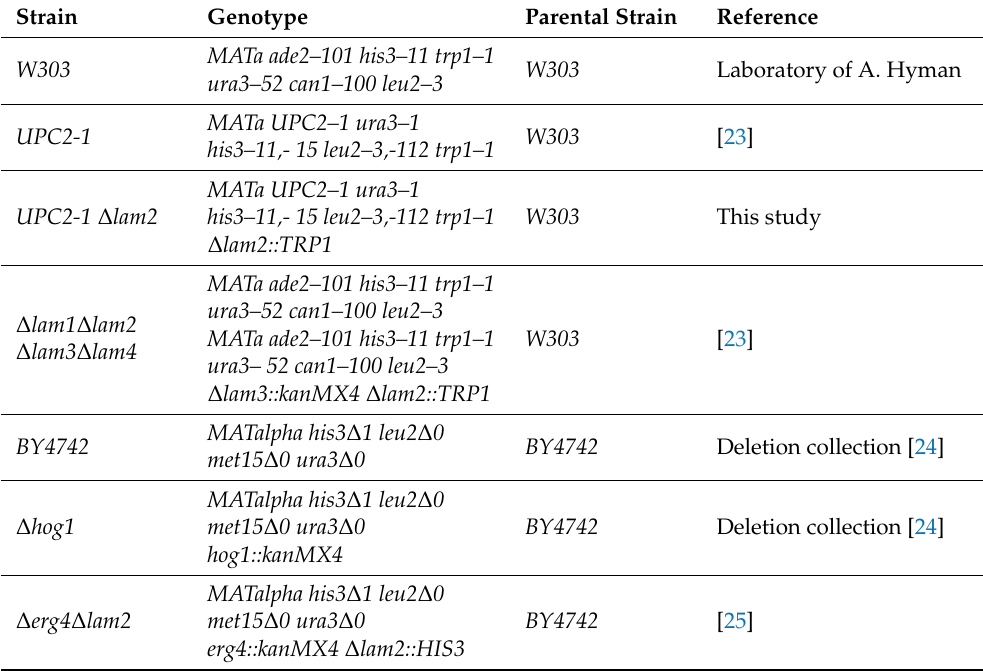
Table 1. Yeast strains used in this